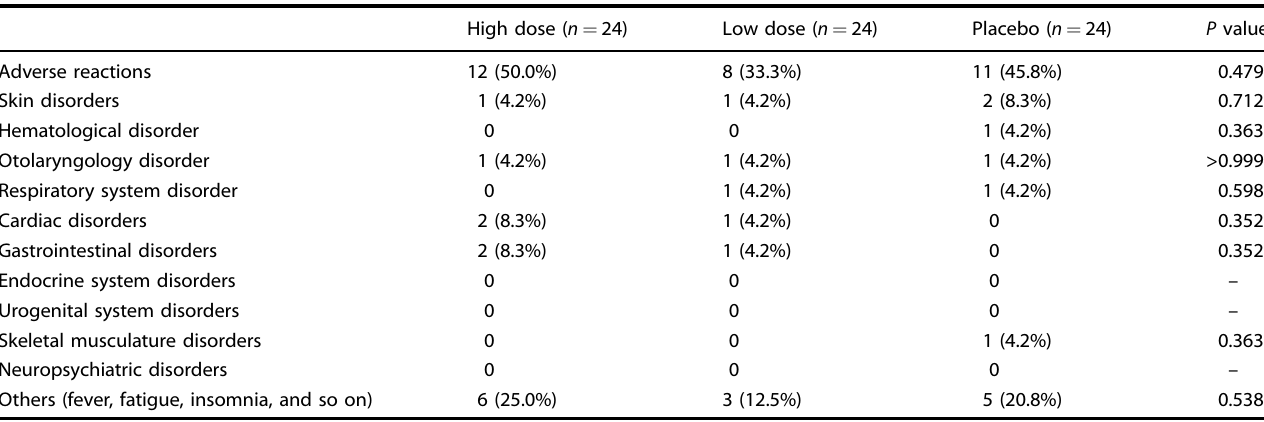
Table 2. Clinical adverse reactions within 96 weeks